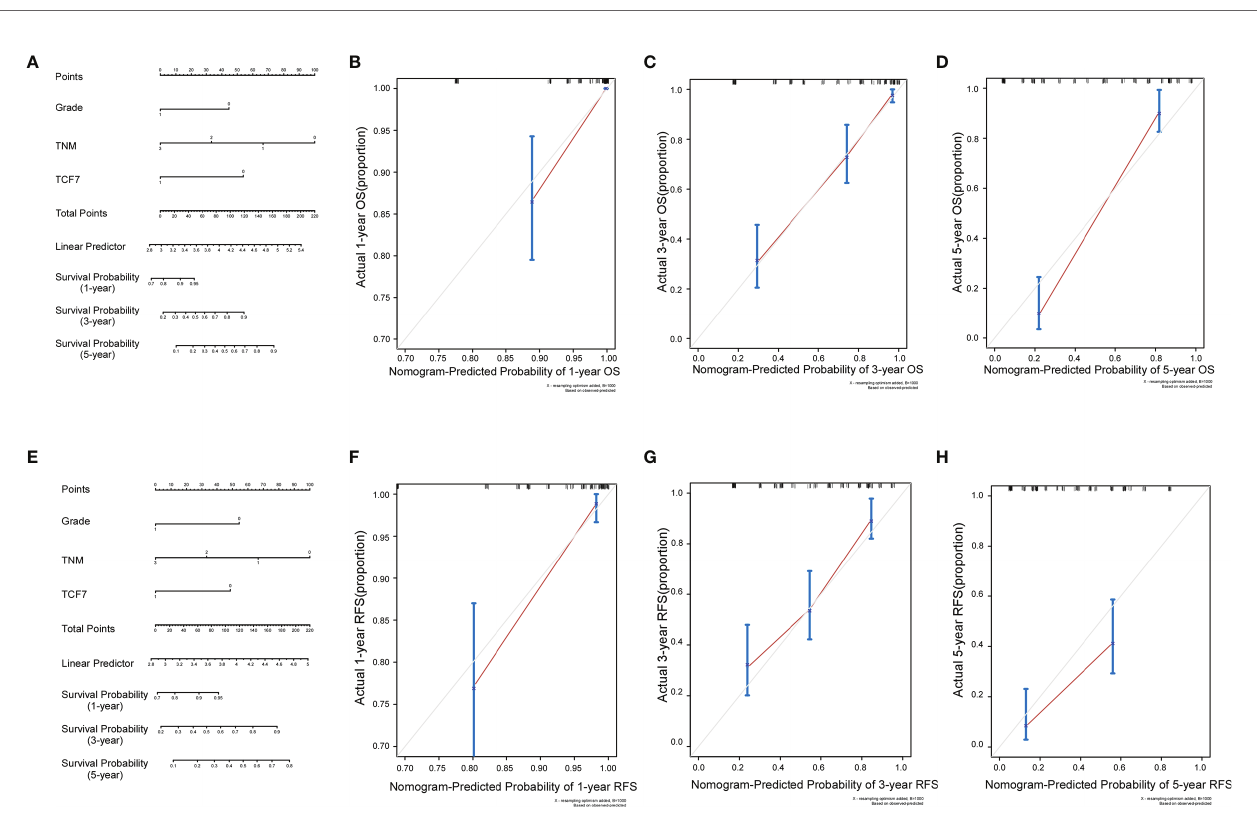
FIGURE 3 | Nomograms and calibration curves of OS versus RFS. Three independent predictors, including TCF7 + T cells, TNM stage, and histological grouping, were incorporated into the nomogram for OS (A) and RFS (E) . Calibration curves were established for predicting OS at 1 year (B) , 3 years (C) and 5 years (D) for OSCC patients and RFS at 1 year (F) , 3 years (G) and 5 years (H) for OSCC patients. OS, overall survival; RFS, recurrence-free